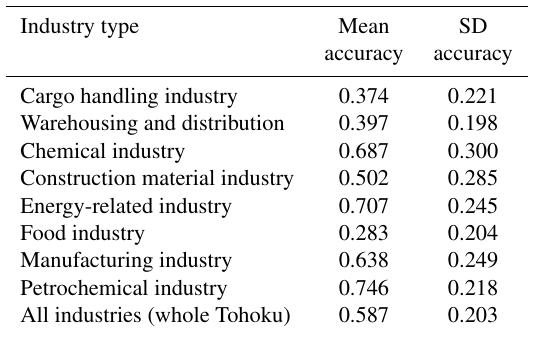
Table 5. Mean accuracies and standard deviations of accuracies of the various port